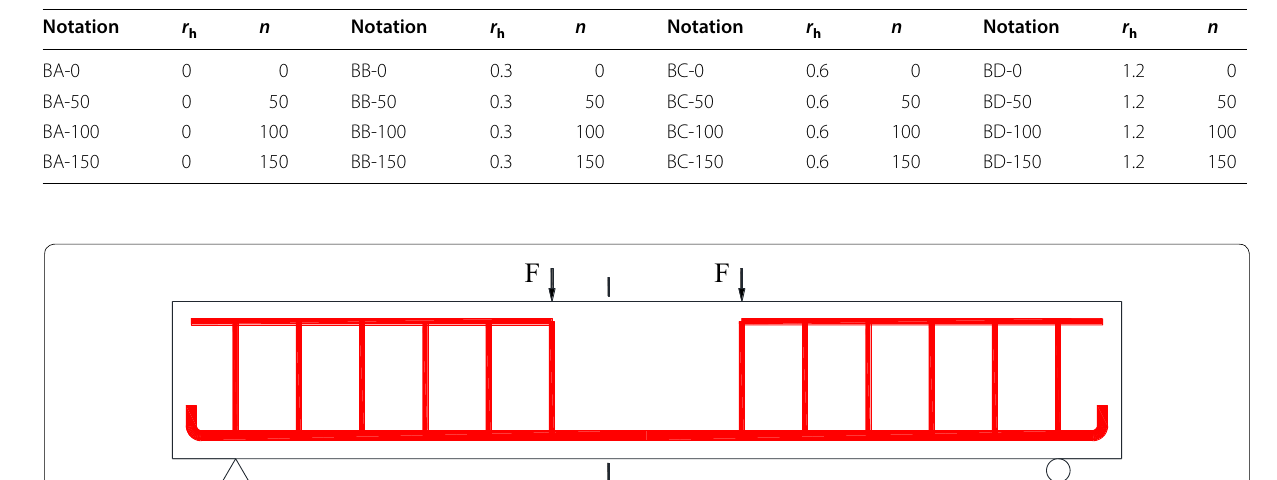
Table 1 Specimen design parameters.